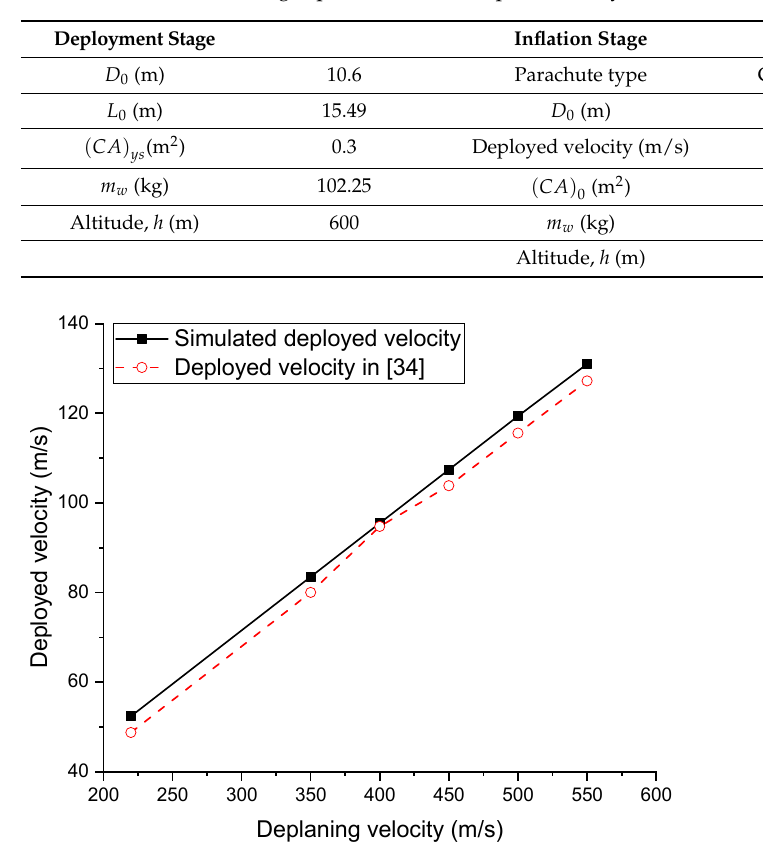
Figure 3. Comparison of parachute deployed velocity with literature.